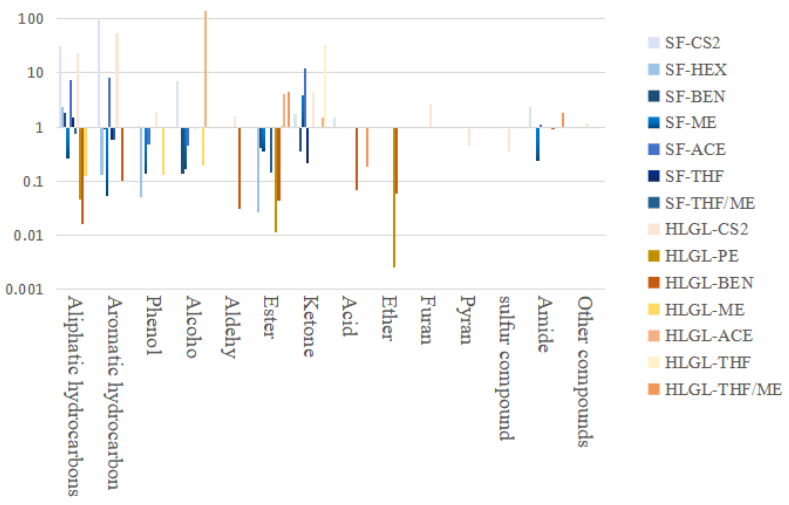
Figure 4. Content distribution of 14 groups of extractant family composition based on GC/MS data.